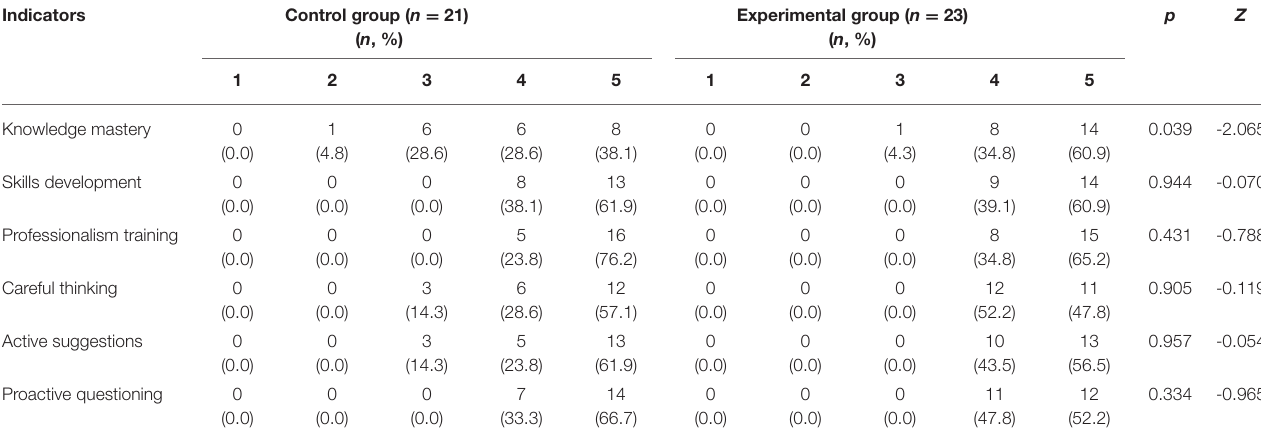
TABLE 3 | Evaluation of the residents’ self-performance. Indicators